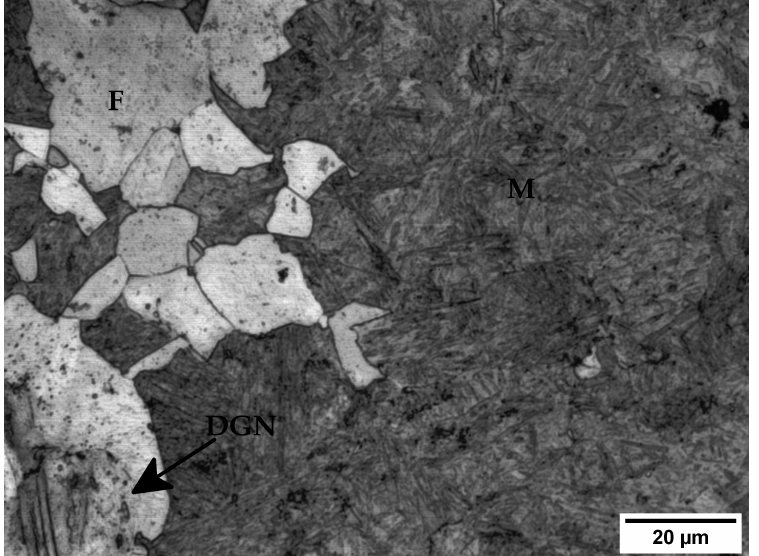
Figure 4. Microstructure of the samples quenched in water after 5 h of annealing at 880 ◦ C. The frac- tion of ferrite is much higher than shown in the figure. DGN: Decarburized graphite nodule; F: Ferrite; M: